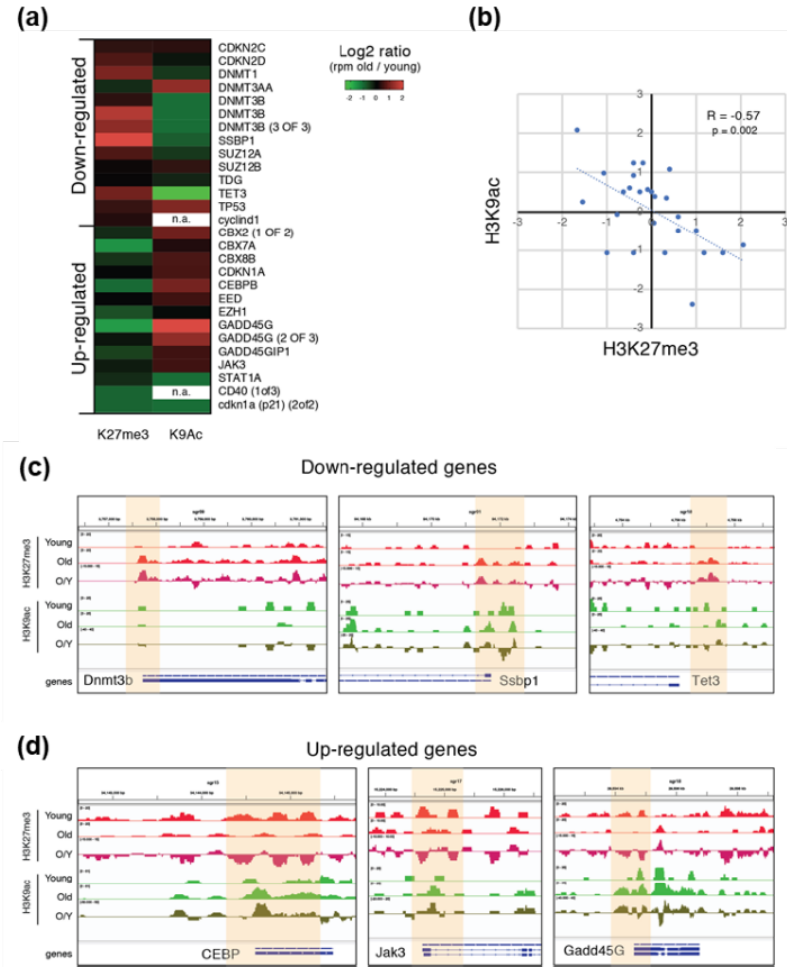
Figure 4. ChIP-seq reveals differential roles of H3K27me3 and H3K9ac in skeletal muscle tissue. ( a ) Heatmap showing the log2 fold change (old/young) of H3K27me3 and H3K9ac signal intensity (RPM) of some of the DEGs during aging (also see Figure S3G). RPM = read per million. ( b ) Log2 fold change (old/young) of H3K27me3 (x axis) and H3K9ac (y axis) signal intensity (RPM). R and p -value is calculated using Pearson correlation. ( c , d ) Genomic view of the ChIP-seq-mapped reads for some DEGs which is down-regulated ( c ) or up-regulated ( d ) during aging.